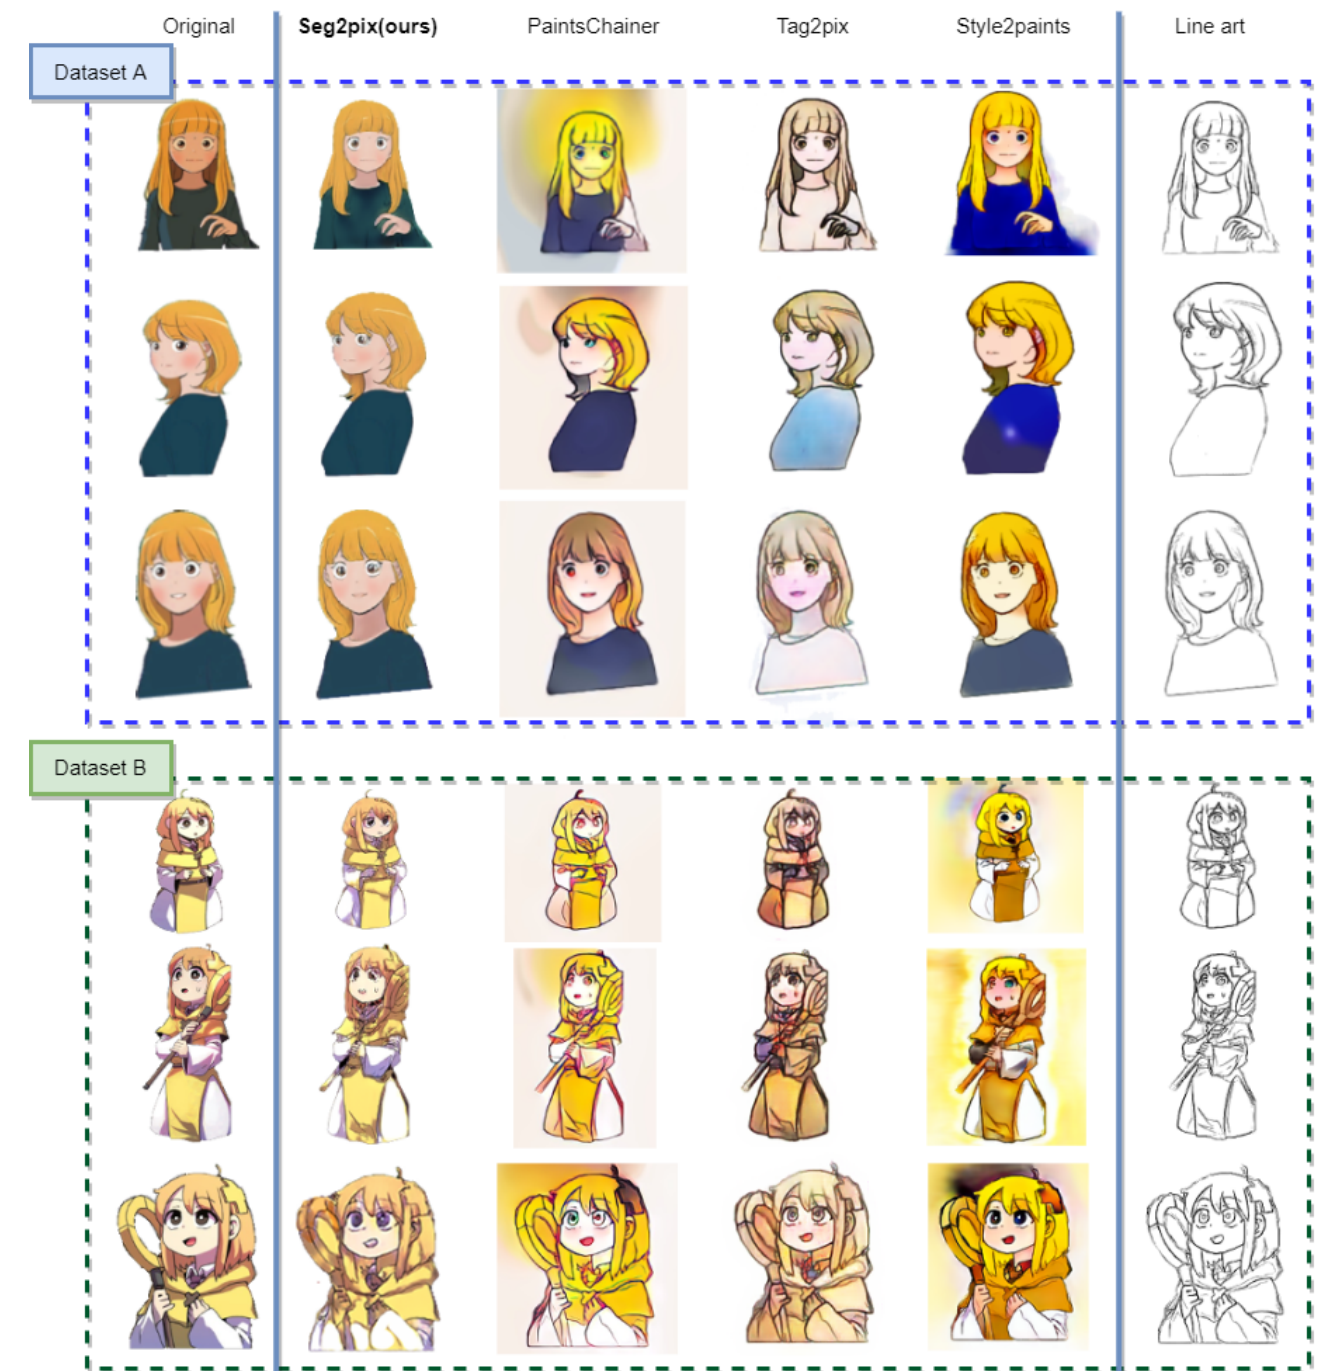
Figure 10. Comparison of the line art colorization results. The first column shows the original ground truth image. Columns 2–5 show the automatic colorization results; from left to right: Seg2pix, PaintsChainer (Canna) [6], Tag2pix [16], and Style2paints [7]. Rows 1–3 of the Seg2pix column are the results from the model trained on Dataset A (Yumi’s cell series), and Rows 4–6 are the results from the model trained on Dataset B (Fantasy sister